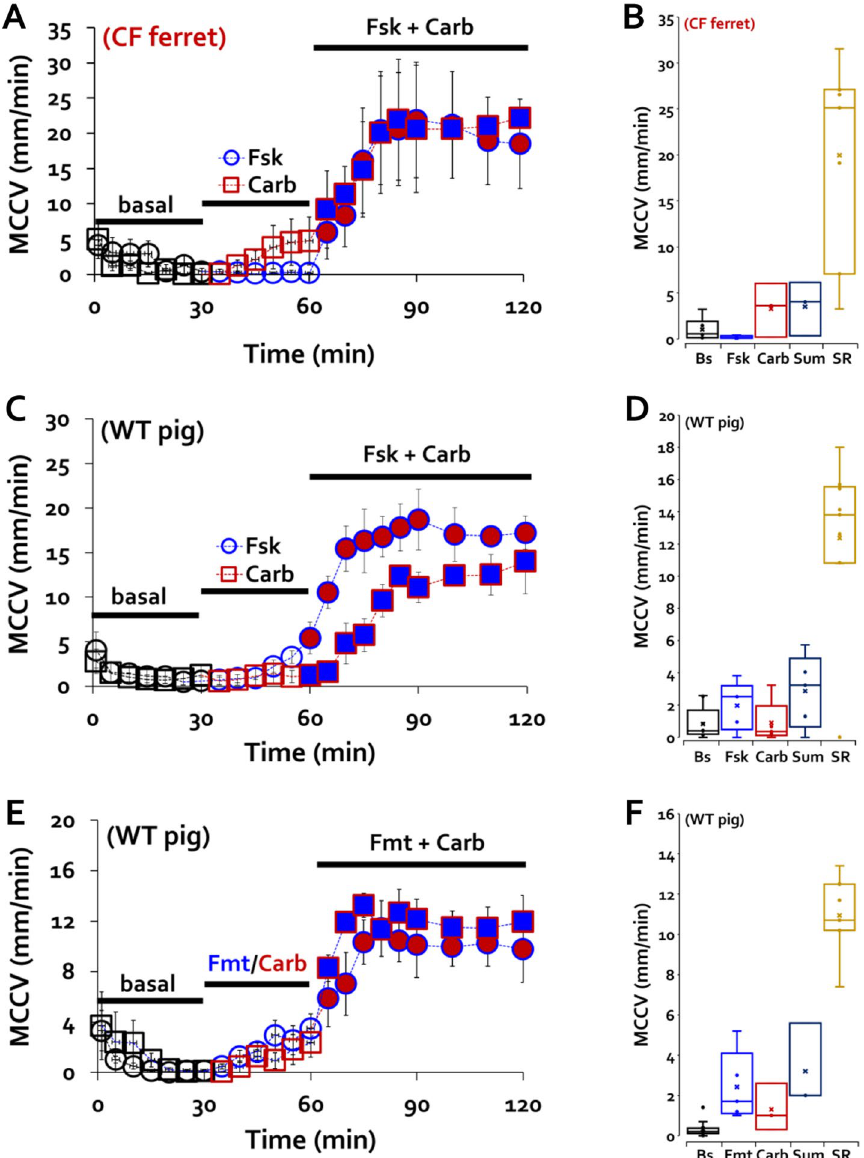
Figure 1. Synergistic mucus clearance in CF ferret and WT pig tracheas. ( A ) Time courses of MCCV from CF ferrets in response to 10 µM forskolin (blue open circles, Fsk, n = 4), 0.3 µM carbachol (red open squares, Carb, n = 4) or the combination (filled symbols). CF ferret genotypes were 5 CFTR G551D , one CFTR ∆F/∆F , and one CFTR G551D/KO . ( B ) Summary data as box and whisker plots. Bs: basal/unstimulated MCCV, Sum: arithmetic sum of MCCV to agonists used separately, SR: synergy to combined agonists. SR was 5.7 times larger than sum, ( P = 0.006, n = 3–7) ( C ) MCCV from 2 to 5-day old piglets: same protocol and symbols as for